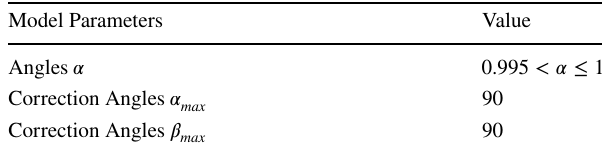
Table 3 Parameters used in SVR-AIG